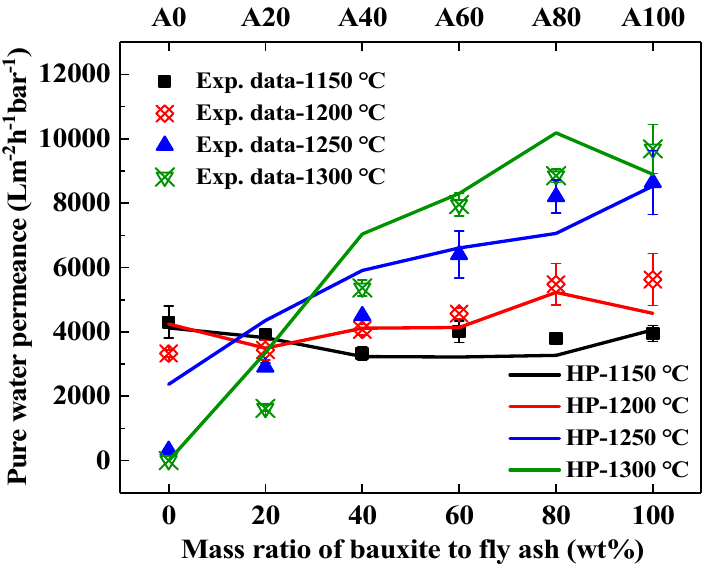
Figure 7. Experimental and calculated pure water permeance of fly ash supports obtained by sintering at different temperatures with different bauxite contents.